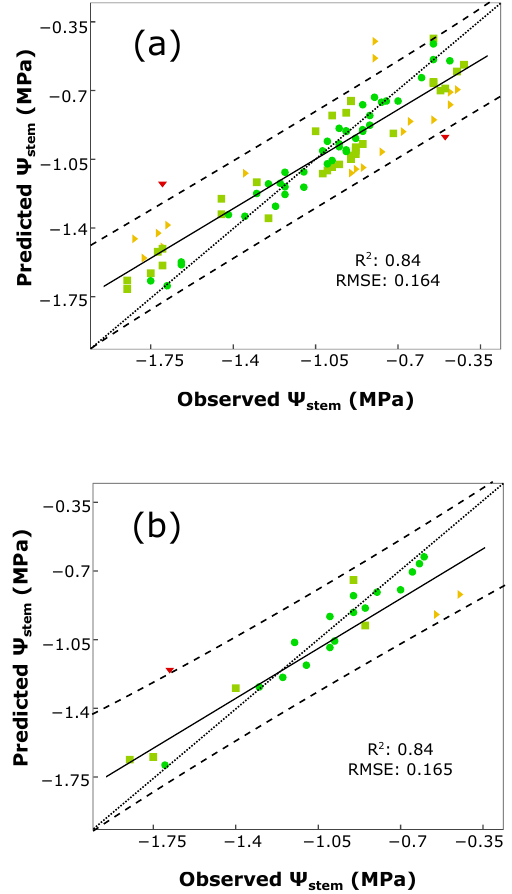
Figure 2. Regression plot for ψ stem estimation using a Rotation Forest and M5 trees with a 5-fold cross ( a ) and external ( b ) validations. Prediction confidence bands are shown at a 95% level (dashed lines). Solid line represents the regression line and dotted line refers to the 1:1 line. Each points’ color and shape refers to its absolute error value | ε | (the absolute value of the difference between the actual value and the predicted one) in MPa: green